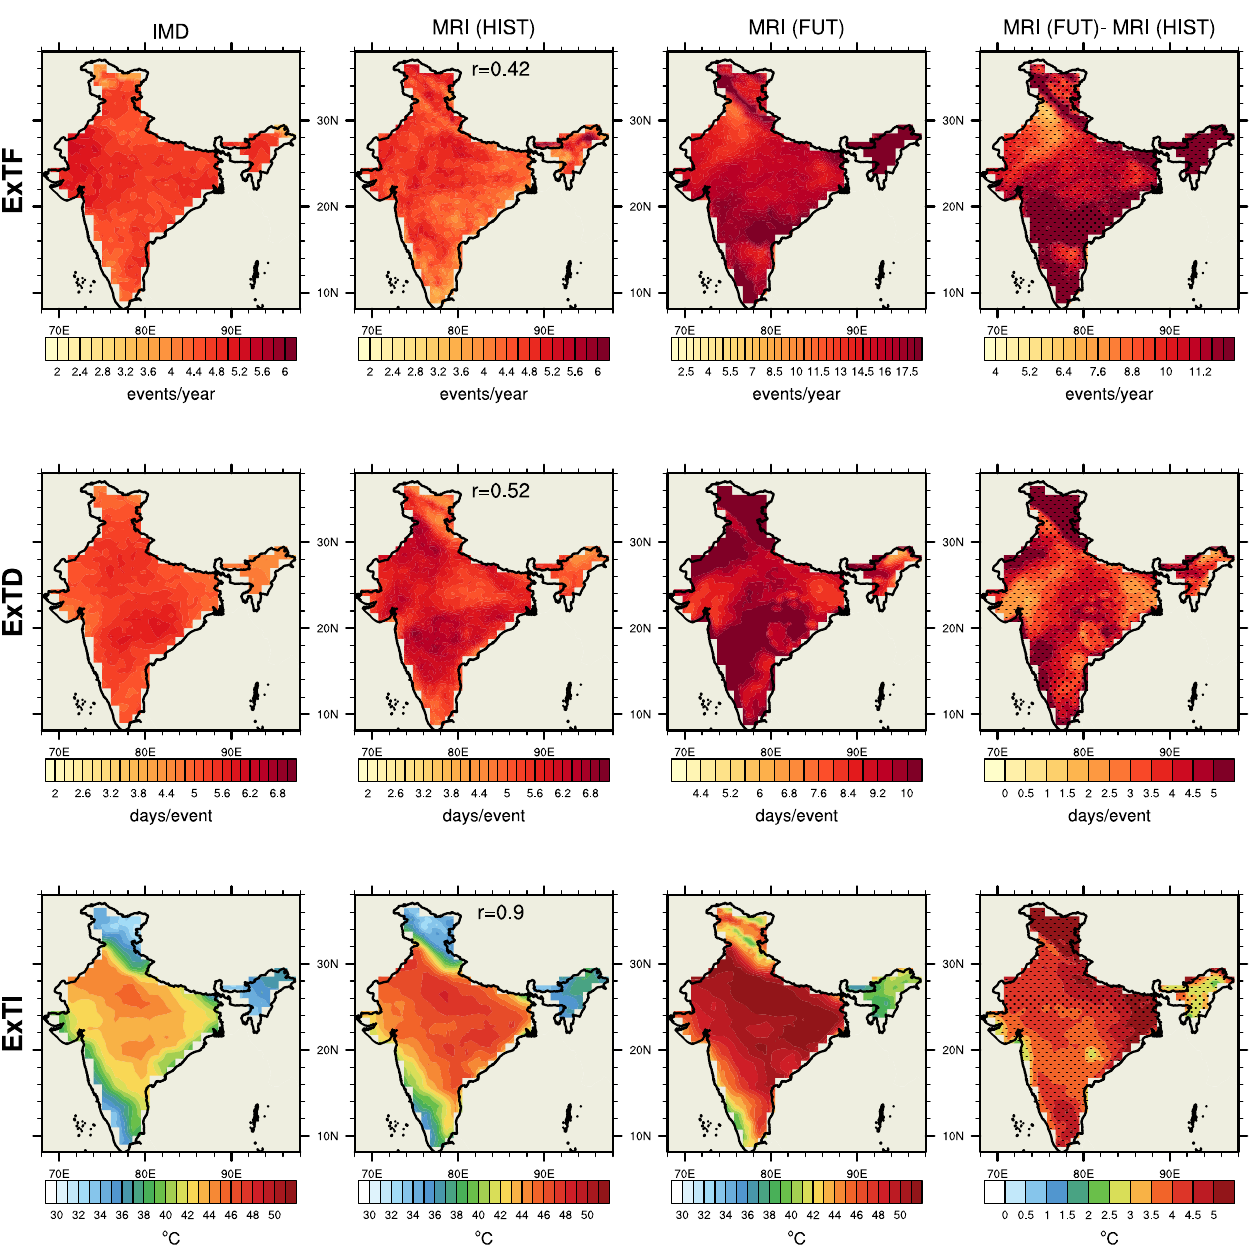
Fig. 4 Temperature extremes over the Indian region. Time-mean spatial maps of extreme temperature frequency (ExTF: 1 st row), duration (ExTD: 2 nd row) and intensity (ExTI: 3 rd row) from the IMD observations (1 st column), HIST experiment (2 nd column), FUT experiment (3 rd column), and difference between the FUT and HIST experiment (4 th column). The pattern correlation coef fi cient (r) between extreme temperature indices from MRI outputs and IMD observations are given in Figures of 2 nd column. Stippling in Figures indicate the regions where difference between the FUT and HIST experiments is signi fi cant at 95% con fi dence impact on ET variability. These regions are mainly located over the north-west, north and north-east parts of India. On the other hand, maximum sensitivity of ET can be observed over moderate SM regimes, where enough SM and radiational energy is available. Quantitatively, a 20% decrease of SM over the transitional climate zone of NCI can lead to a decline in ET by 10%, and a 20% increase of SM can enhance the ET by 15%. Furthermore, by limiting the total available energy for the latent heating process, SM dominantly controls the surface energy partitioning at the land surface 20 . A 20% decrease of SM over the NCI leads to contribute more radiational energy for sensible heating process by limiting the energy used for LHF (Fig. 10). An